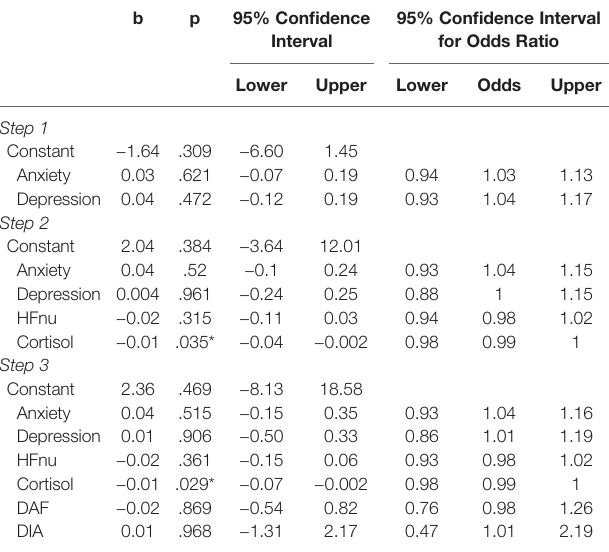
TABLE 3 | Summary of hierarchical logistical regression analysis predicting the presence of ulcerative colitis (UC) (95% BCa bootstrap con fi dence intervals based on 5,000 samples).